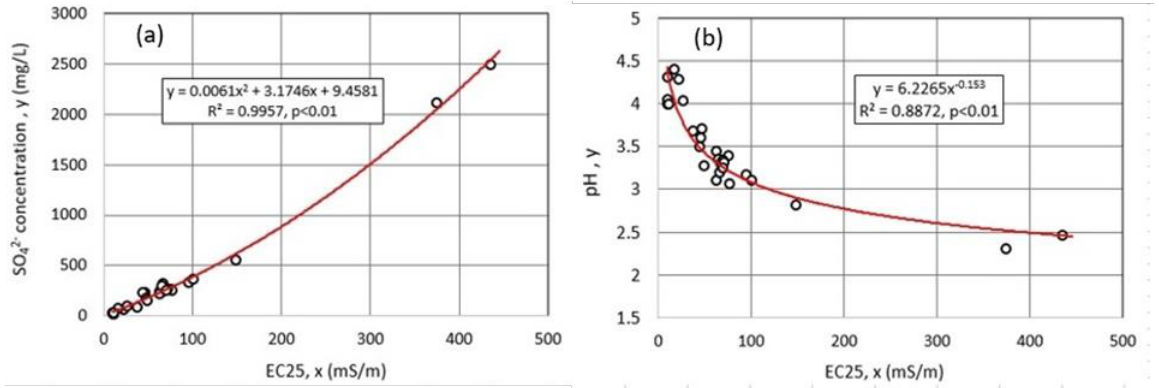
Figure 4. Relationships between EC25 (mS/m) and ( a ) SO 42 − concentration (mg/L) and ( b ) pH for the lake, stream, and spring waters.